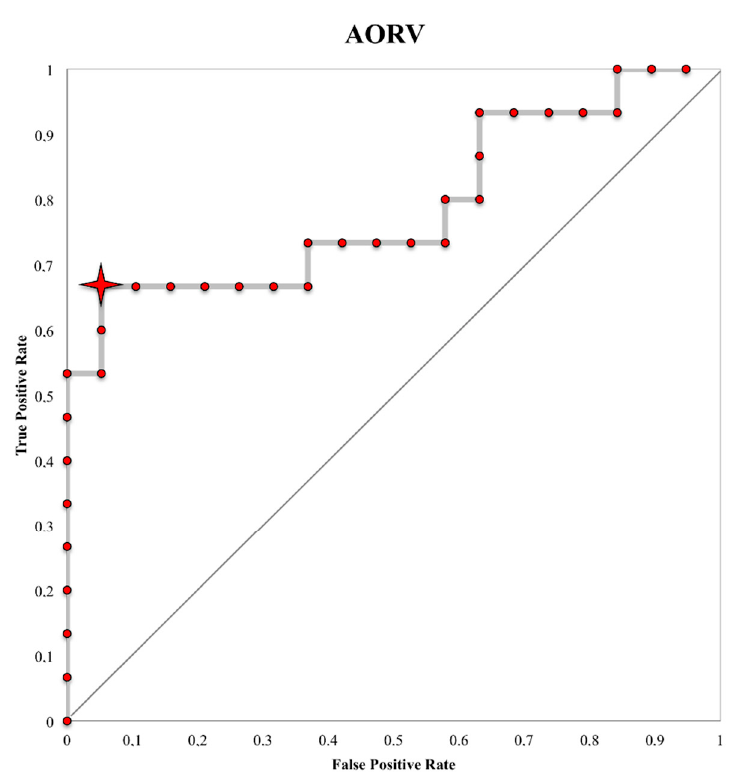
Figure 5. Affected ovary relative volume (AORV) receiver operating characteristic (ROC) curve at the antimüllerian hormone (AMH) cut-off of 2 ng/mL. Red star, AORV cut-off value of 5.96.